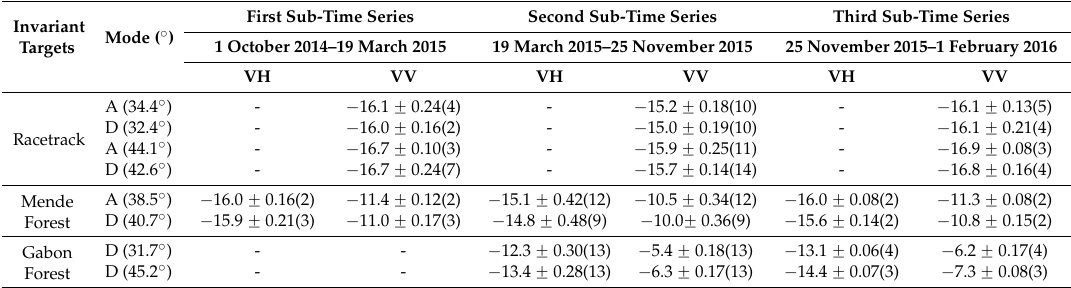
Table 1. For each invariant target, the mean (M) and standard deviation (SD) of σ ˝ -values for each sub-time series. The format is: M ˘ std (number of points). σ ˝ -values perturbed by rainfall were not used in the statistical calculations. A: Ascending mode; D: Descending